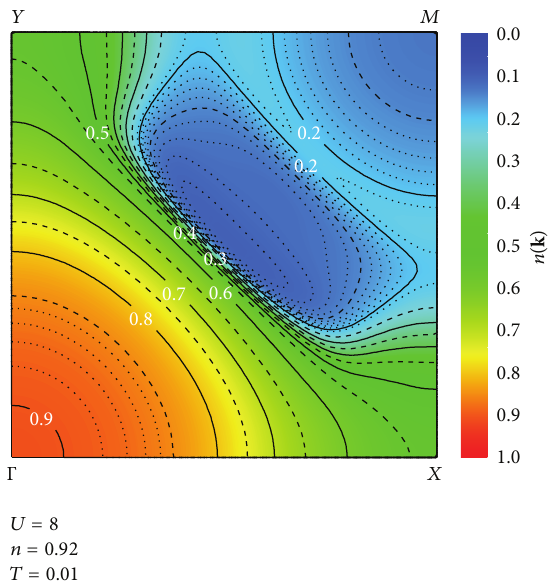
Figure 8: (Color online) The momentum distribution function 𝑛( k ) for 𝑛 = 0.92 , 𝑇 = 0.01 , and 𝑈 = 8